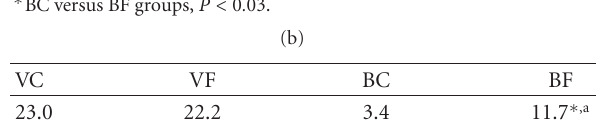
Figure 1: Weight gain in rats fed 15% (w/w) corn oil or 15% (w/w) flaxseed oil diet. Bleomycin and vehicle administration occurred at day 26. Data are expressed as means ± SEM, n = 13–15. At day 33 (or 7 days after bleomycin administration), there was significantly less weight loss in the BF treated rats than the BC treated rats ( P < 0 . 03).